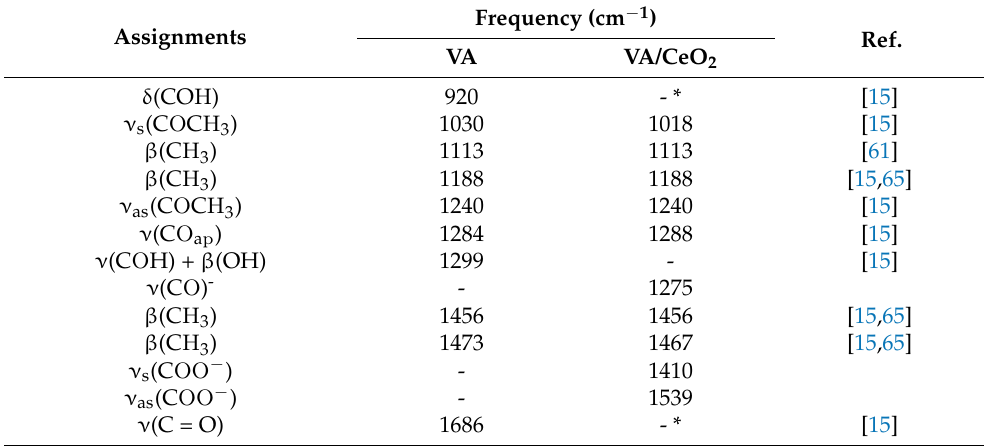
Figure 3. Fourier transform-infrared (FT-IR) spectra of pure CeO 2 (a), samples of VA/CeO 2 with different contents of VA (0.1: b; 0.3: c; 0.6: d; 0.9: e; 1.2 mmol/g: f) and pure VA (g). Table 3. Assignments of characteristic infrared bands of pure VA and of VA/CeO 2 (0.6